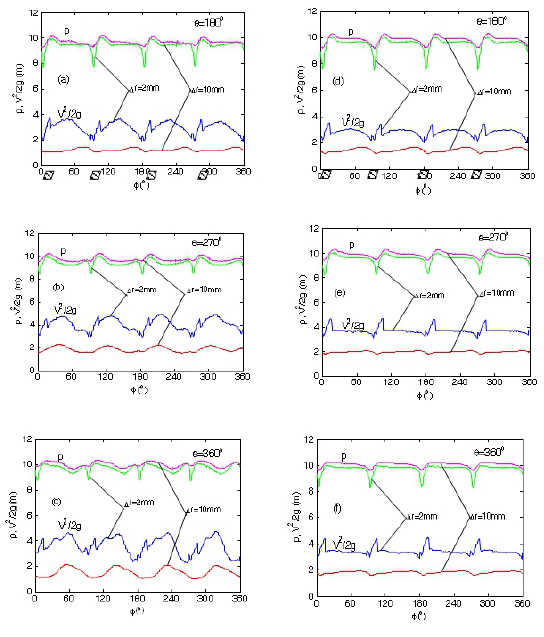
Figure 7. Pressure and velocity heads in terms of impeller rotating angle at best efficiency point when delivering water (a)-(c) and viscous oil